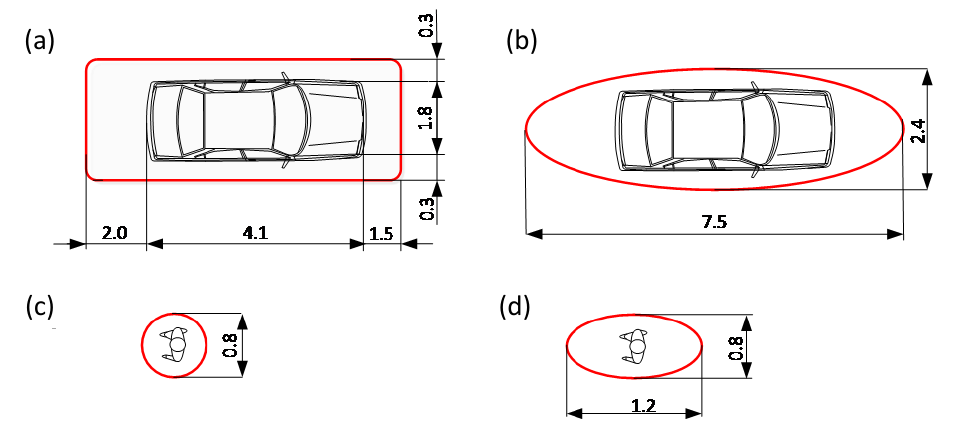
Figure 5. Size of the safety zone dimensions used in the simulation; ( a ) vehicle rectangular, ( b ) ve- hicle elliptical, ( c ) pedestrian circular, ( d ) pedestrian elliptical.